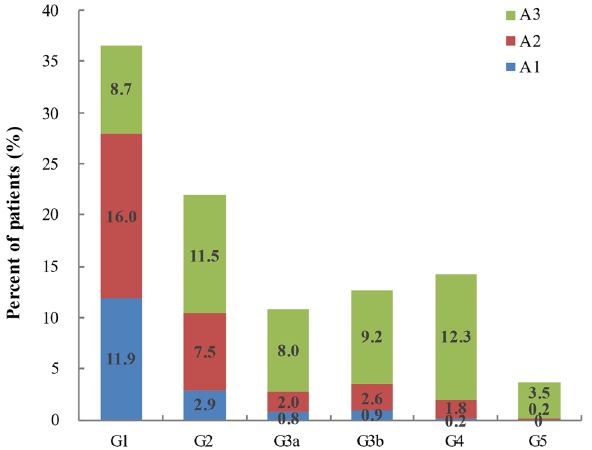
Figure 1. Proportion of patients with DKD in each eGFR and albuminuria category. A1–A3 denote albuminuria category. Albuminuria categories: A1, < 30 mg/g; A2, 30–300 mg/g; A3, > 300 mg/g. G1–G5 denote GFR categories: G1, ≥ 90 ml/min/1.73 m 2 ; G2, 60–89 ml/min/1.73 m 2 ; G3a, 45–59 ml/min/1.73 m 2 ; G3b,